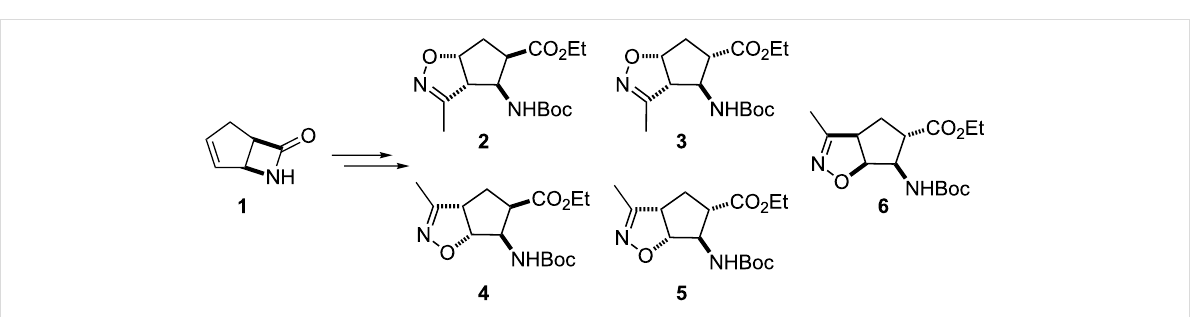
Scheme 1: Isoxazoline-fused β -aminocyclopentanecarboxylate regio- and stereoisomers